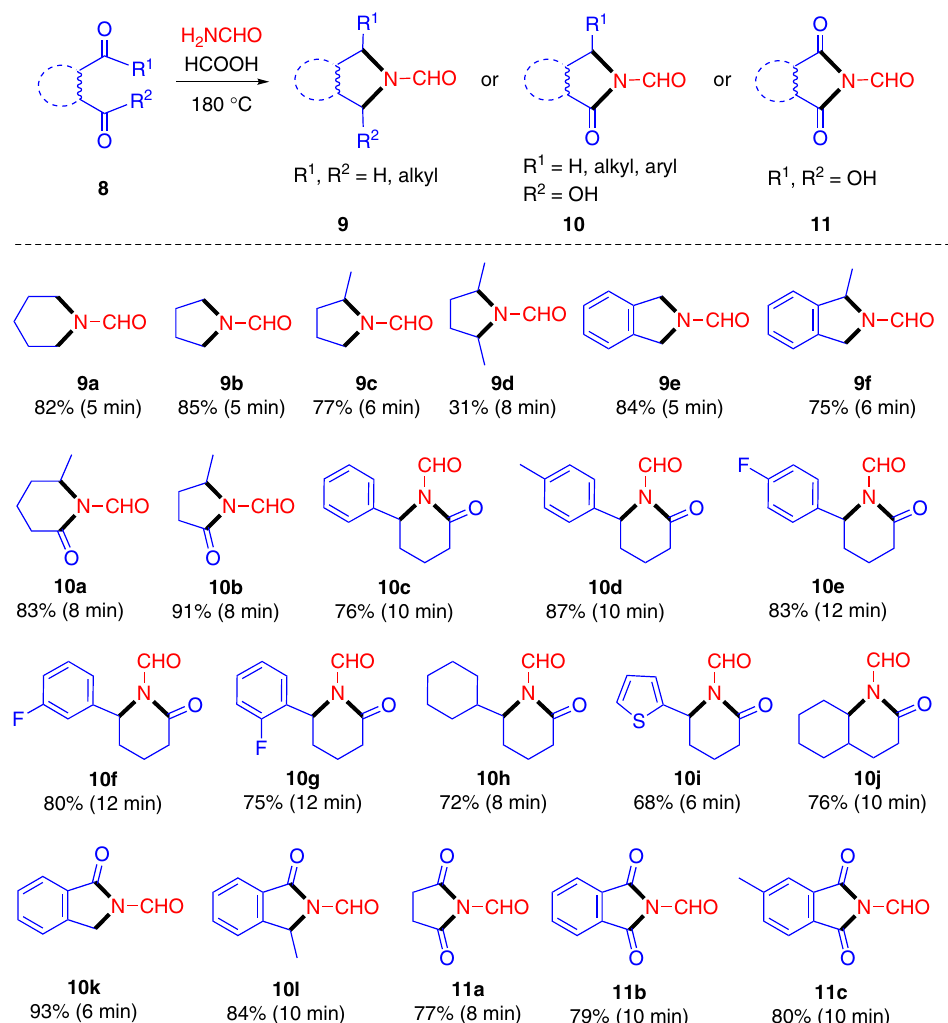
Fig. 6 Synthesis of N-formyl cyclamines ( 9 ), N-formyl lactams ( 10 ), or N-formyl cyclic imides ( 11 ) from AM and dicarbonyl compounds ( 8 ). Reaction conditions: 1 mmol 8 , 8 mmol AM, 12 mmol FA, 180 °C